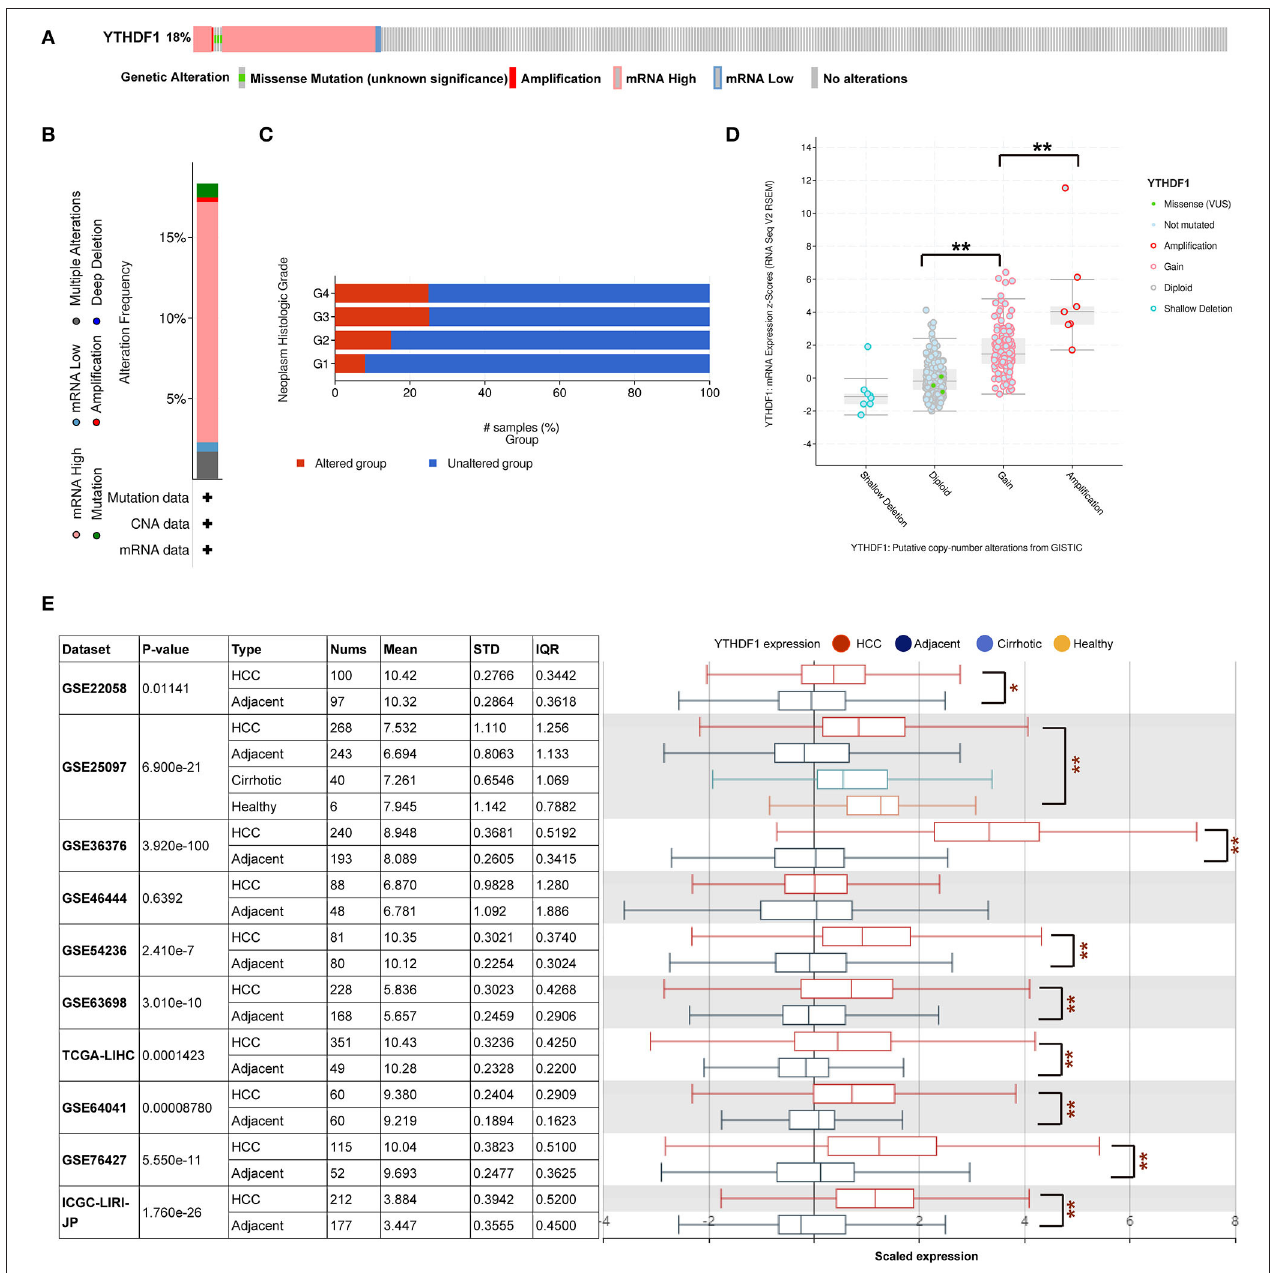
FIGURE 4 | YTHDF1 genomic alterations in hepatocellular carcinoma (HCC). (A,B) OncoPrint of YTHDF1 alterations in liver hepatocellular carcinoma (LIHC) cohort identified by cBioPortal. (C) YTHDF1 mRNA expression in different YTHDF1 copy number variation (CNV) groups. (D) Distribution of YTHDF1 CNV frequency in LIHC cases at different grades. (E) YTHDF1 expression in 10 Gene Expression Omnibus (GEO) datasets. * P < 0.05, ** P <